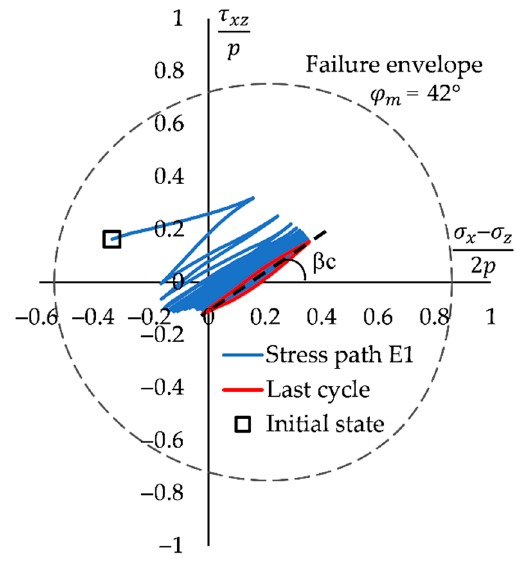
Figure 5. Stress path for element E1.